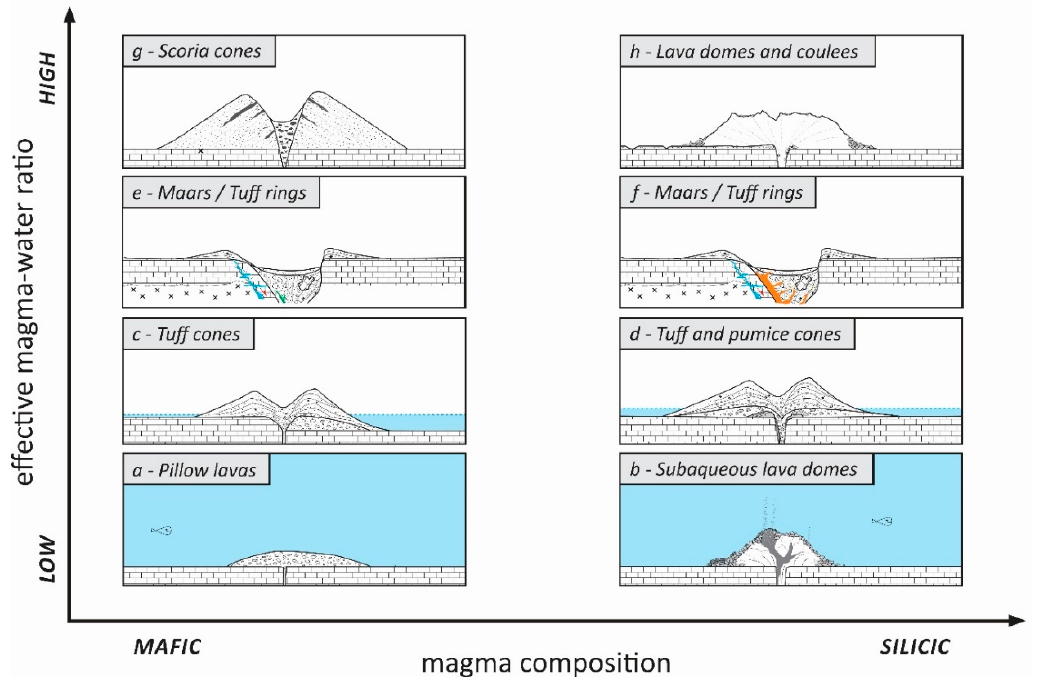
Figure 4. Typical architecture of mafic and silicic small-volume volcanic edifices formed within deep subaqueous to subaerial environments and resulting different effective magma-water ratios (after Wohletz and Sheridan, 1983 [213]). At deep subaqueous environment volcanic activity mostly controlled by the hydrostatic pressure allowing mostly effusive activity (e.g., pillow lavas or hyaloclastites) ( a , b ). In shallow subaqueous environment explosive eruptions can take place and form tuff/pumice cones ( c , d ). Silicic tuff cones usually composed of angular lithic fragments (e.g., obsidian). In subaerial settings small-volume eruptions may dominated by phreatomagmatic eruptions and form maar-diatreme volcanoes ( e , f ). Silicic systems often characterized by long-lived hydrothermal system and ore mineralization ( f ). Eruptions that are influenced by minor or ad hoc interaction with external water usually insignificant to be expressed in the large-scale architecture of volcanic edifices. However, some phases of the eruptions may differ significantly from typical mafic Strombolian eruptions or effusive emplacement of lava domes of silicic systems ( g , h ).